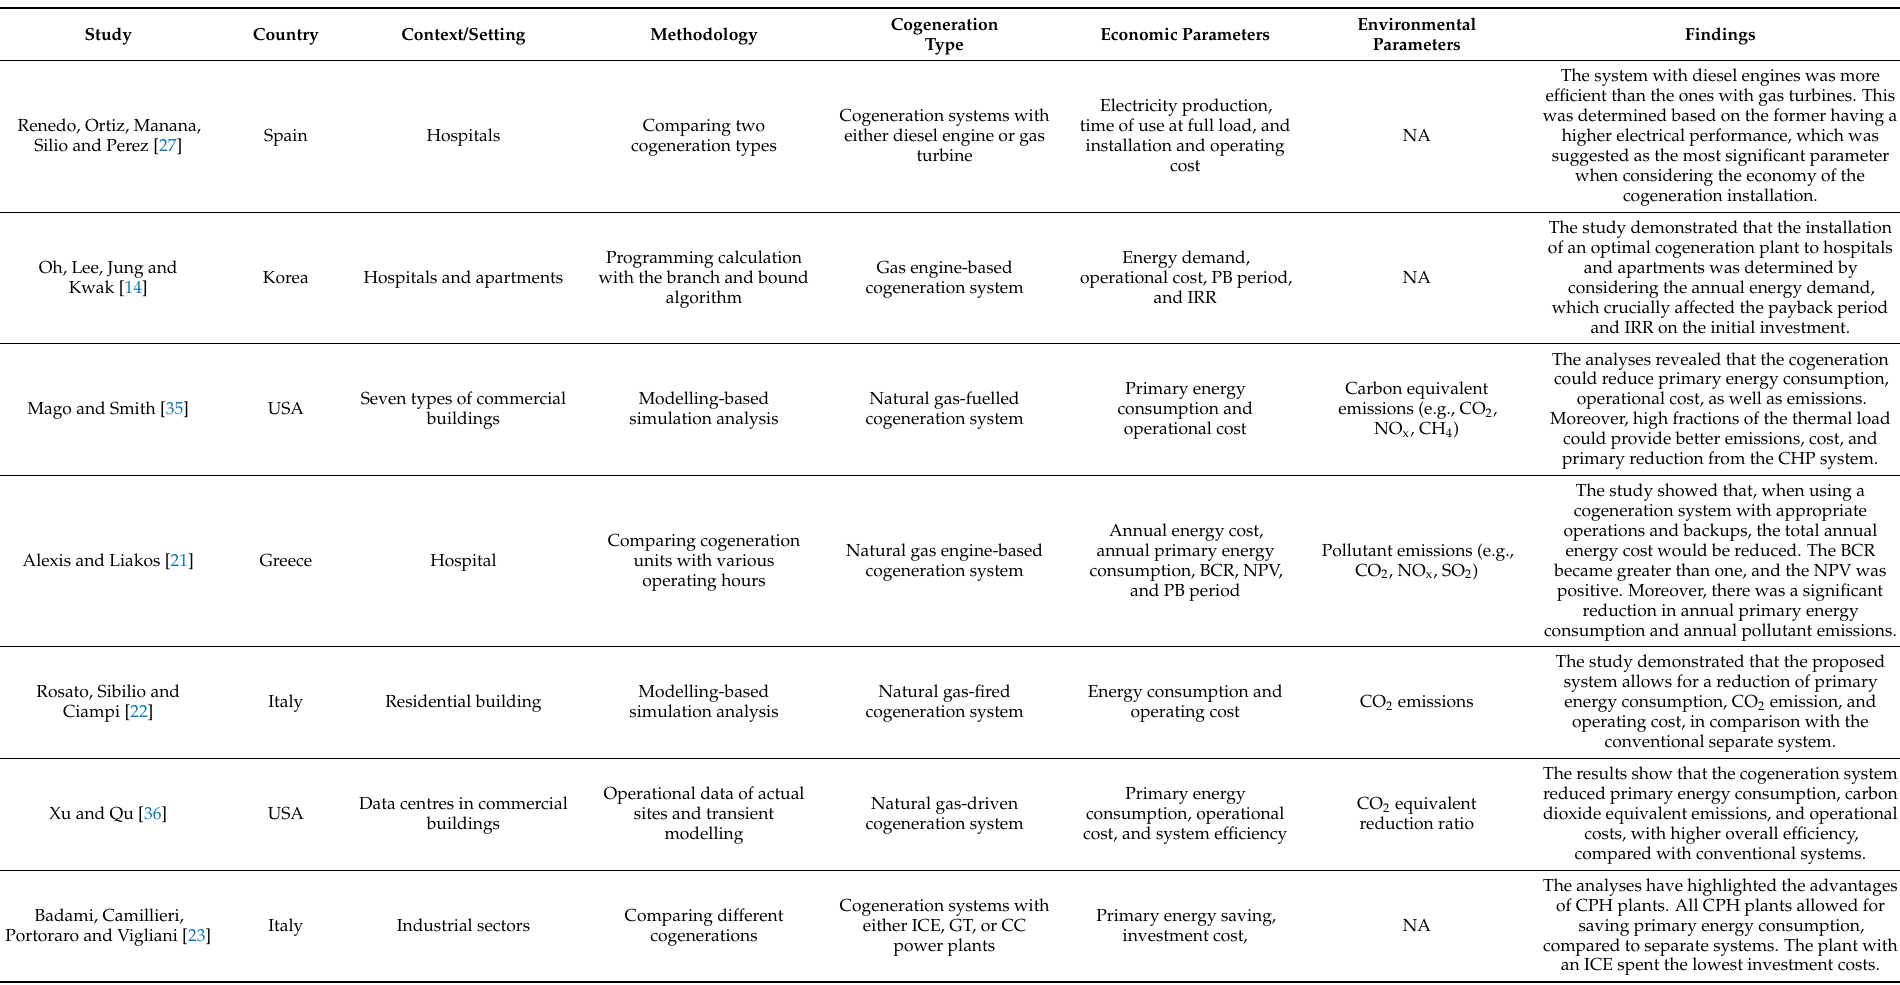
Table 1. Summary of the included